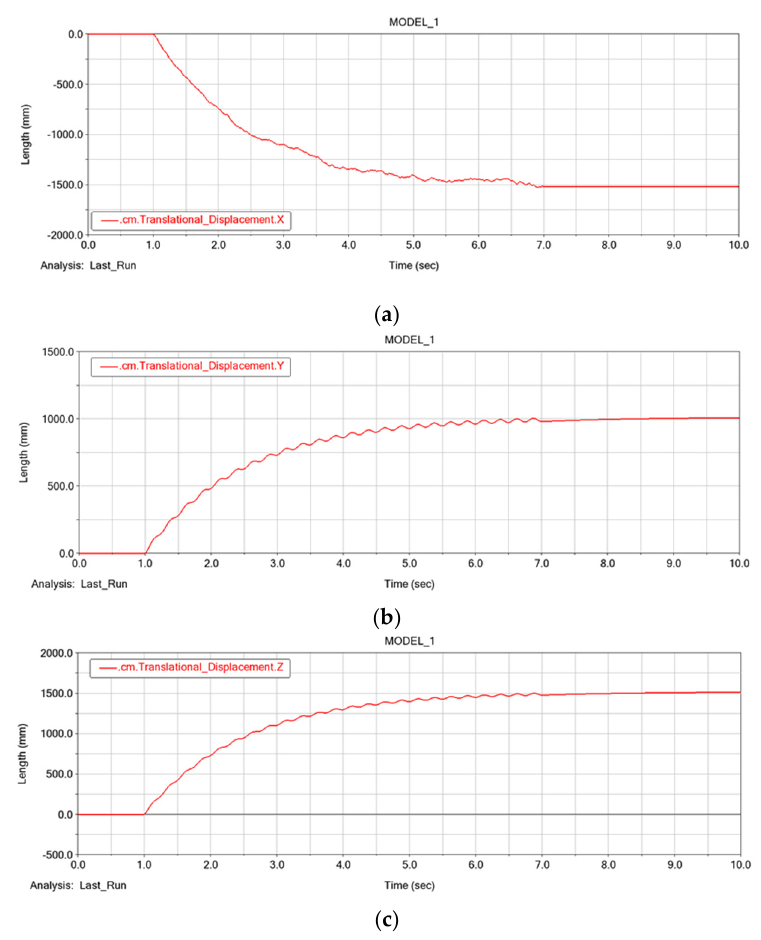
Figure 16. The moving trajectory of the centroid of the robot: ( a ) displacement curve of the centroid in the X direction; ( b ) displacement curve of the centroid in the Y direction; ( c ) displacement curve of the centroid in the Z direction.